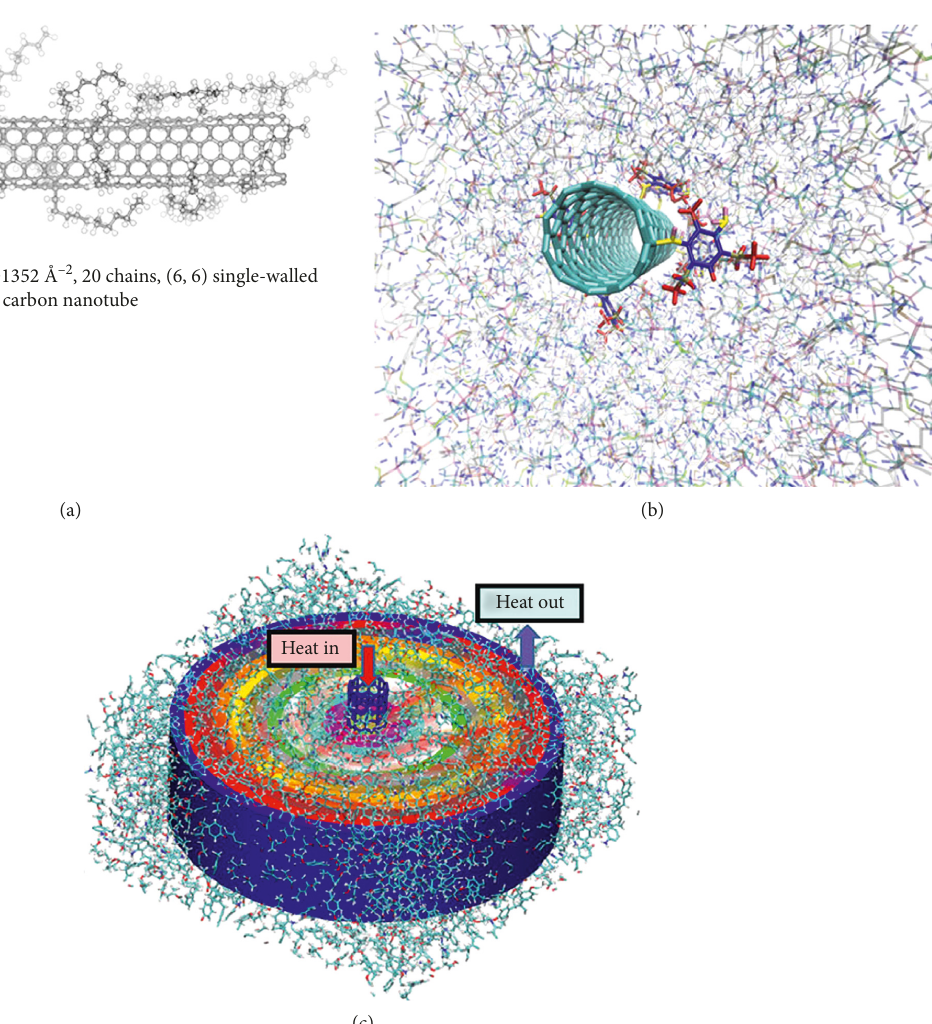
Figure 15: (a) An individual single-walled carbon nanotube with short end-grafted chains. (b) Schematic diagram of an individual single- walled carbon nanotube functionalized with crosslinker diethylenetoluenediamine and embedded in an epoxy matrix. Carbon nanotubes are rendered in cyan. The color scheme for the functionalized diethylenetoluenediamine molecule (red: hydrogen and carbon atoms contained in methyl groups, yellow: nitrogen atoms, and blue: carbon atoms contained in benzene rings. (c) Schematic diagram of a single- walled carbon nanotube-epoxy nanocomposite with different interfacial thicknesses. The nanocomposite exists in an epoxy environment, with the carbon nanotube as heat source and the interfacial region close to the polymer matrix as heat sink (adapted with permission from